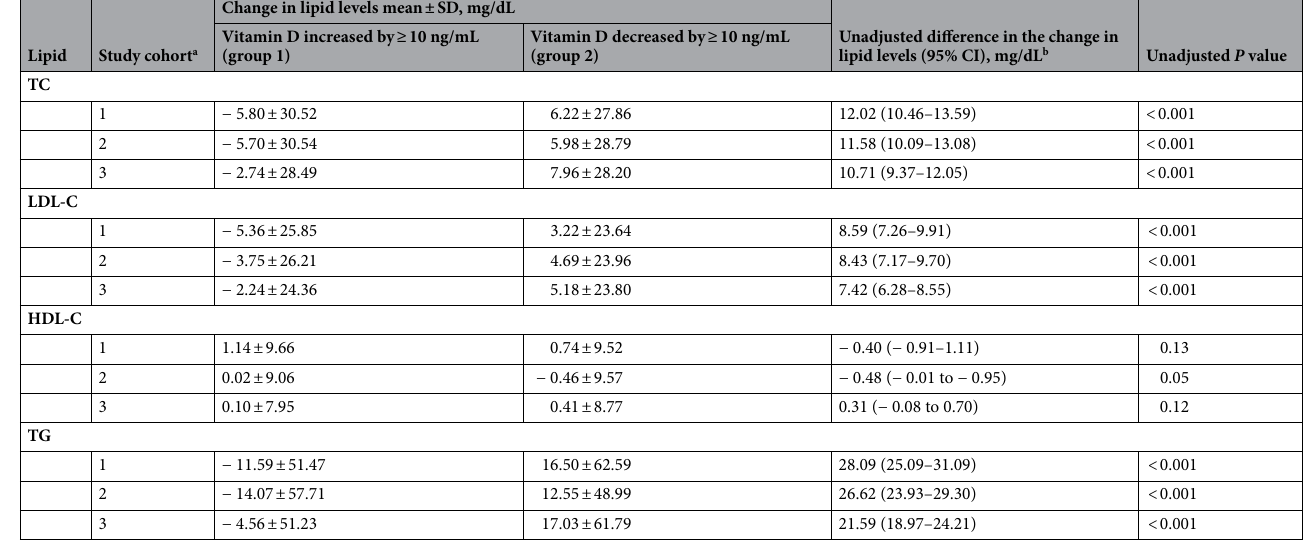
Table 2. Changes in lipid levels according to changes in vitamin D levels. TC: total cholesterol; LDL-C: low- density lipoprotein cholesterol; HDL-C: high-density lipoprotein cholesterol; TG: triglycerides; CI: confidence interval; SD: standard deviation. a Cohort 1: 2018 versus 2017; cohort 2: 2019 versus 2018; cohort 3: 2020 versus 2019. b Difference between group 2 and group